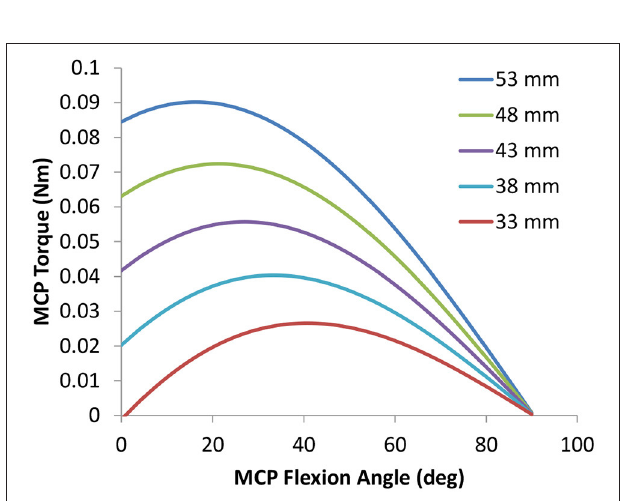
FIGURE 2 | Typical Torque vs. Angle assistance curves for the MCP joint. The shape and peak torque change as the maximum spring length denoted in the legend is adjusted with the MCP knob. Similar profiles were applied to the PIP